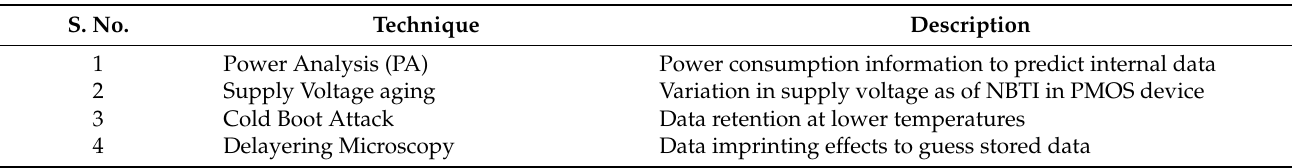
Table 4. Summary of data attack techniques to sneak into the SRAM